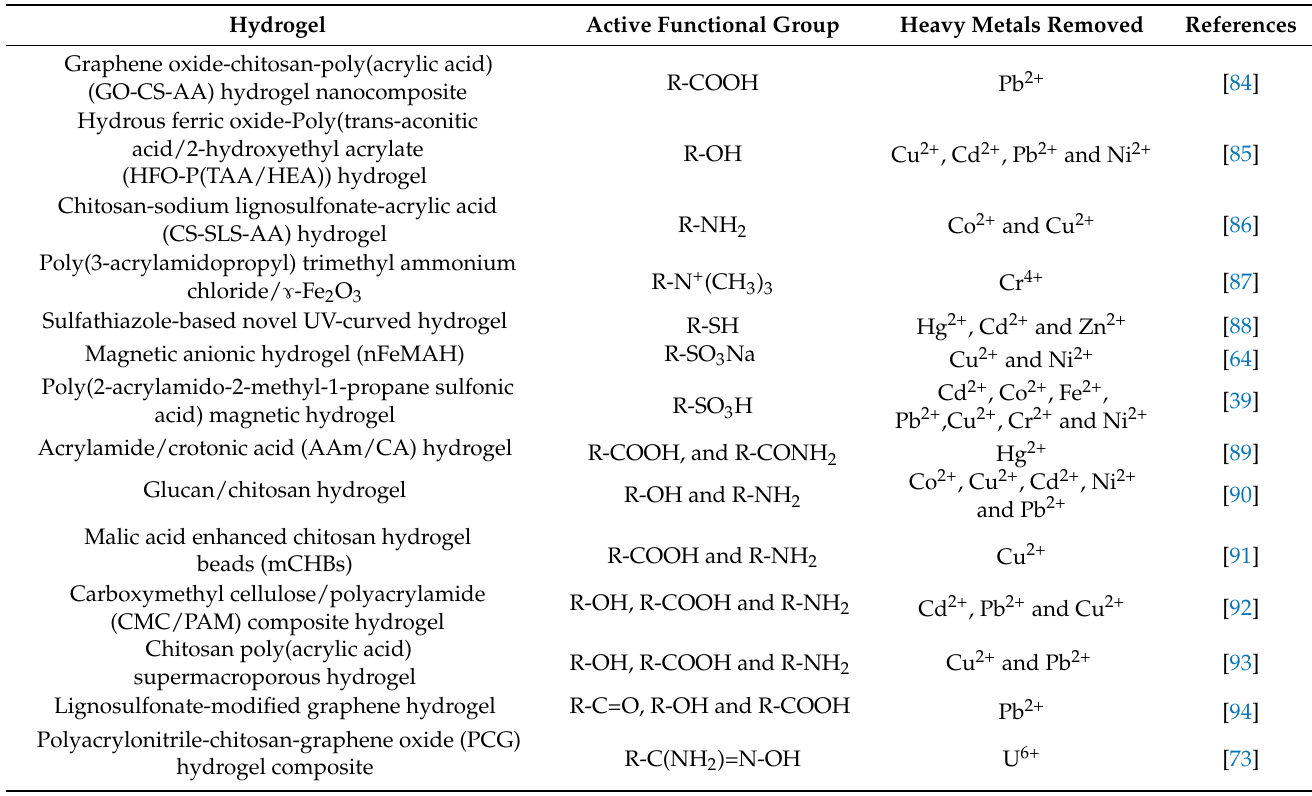
Table 3. Different hydrogel-based functionalized adsorbent materials for the removal of heavy metals.